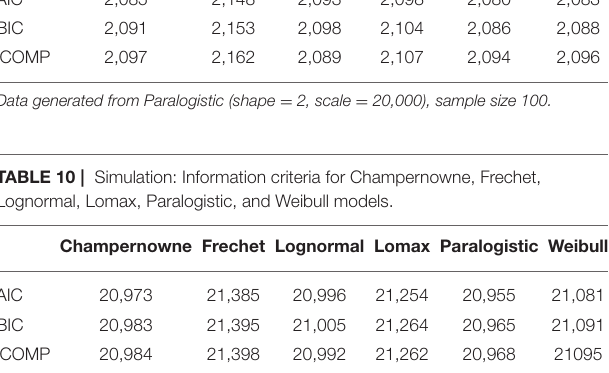
TABLE 4 | Simulation: Information criteria for Champernowne, Frechet, Lognormal, Lomax, Paralogistic, and Weibull models. Champernowne Frechet Lognormal Lomax Paralogistic Weibull AIC 24,051